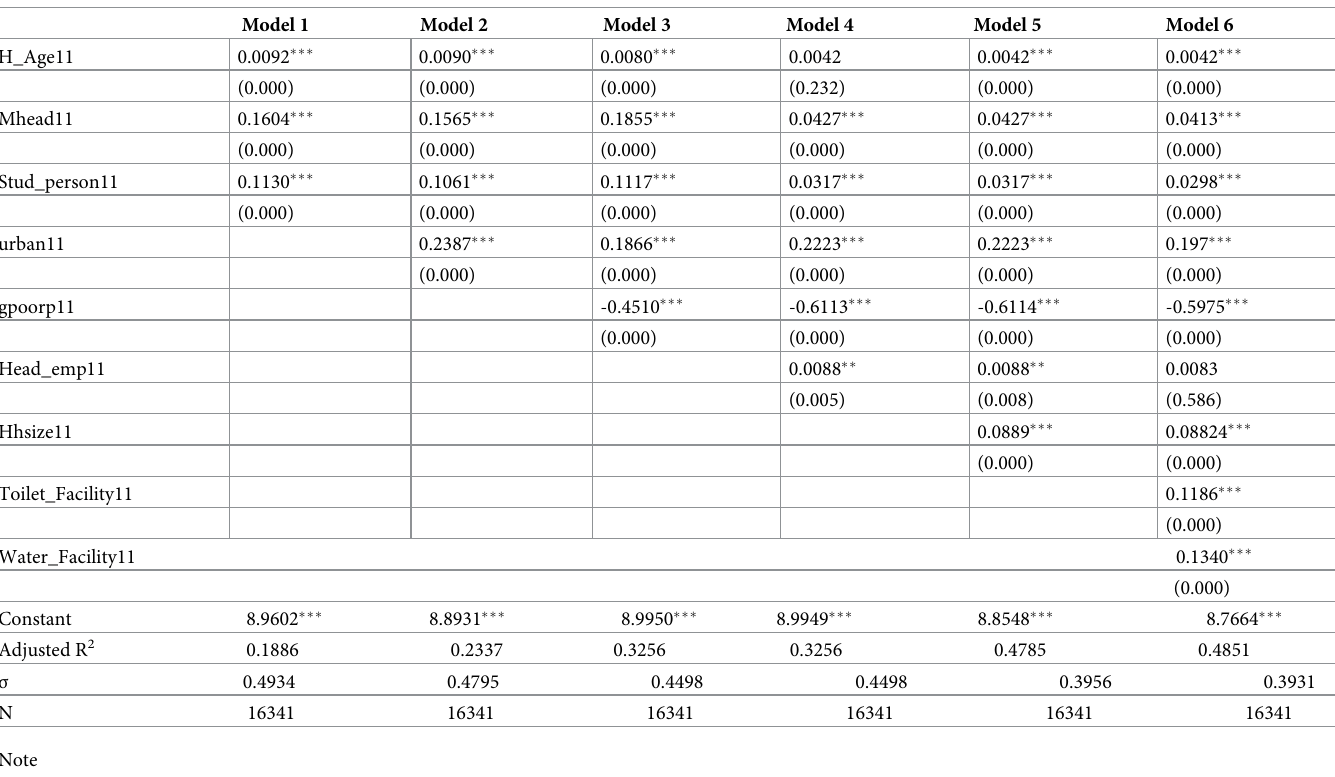
Table 9. Household consumption estimated parameter, Pakistan